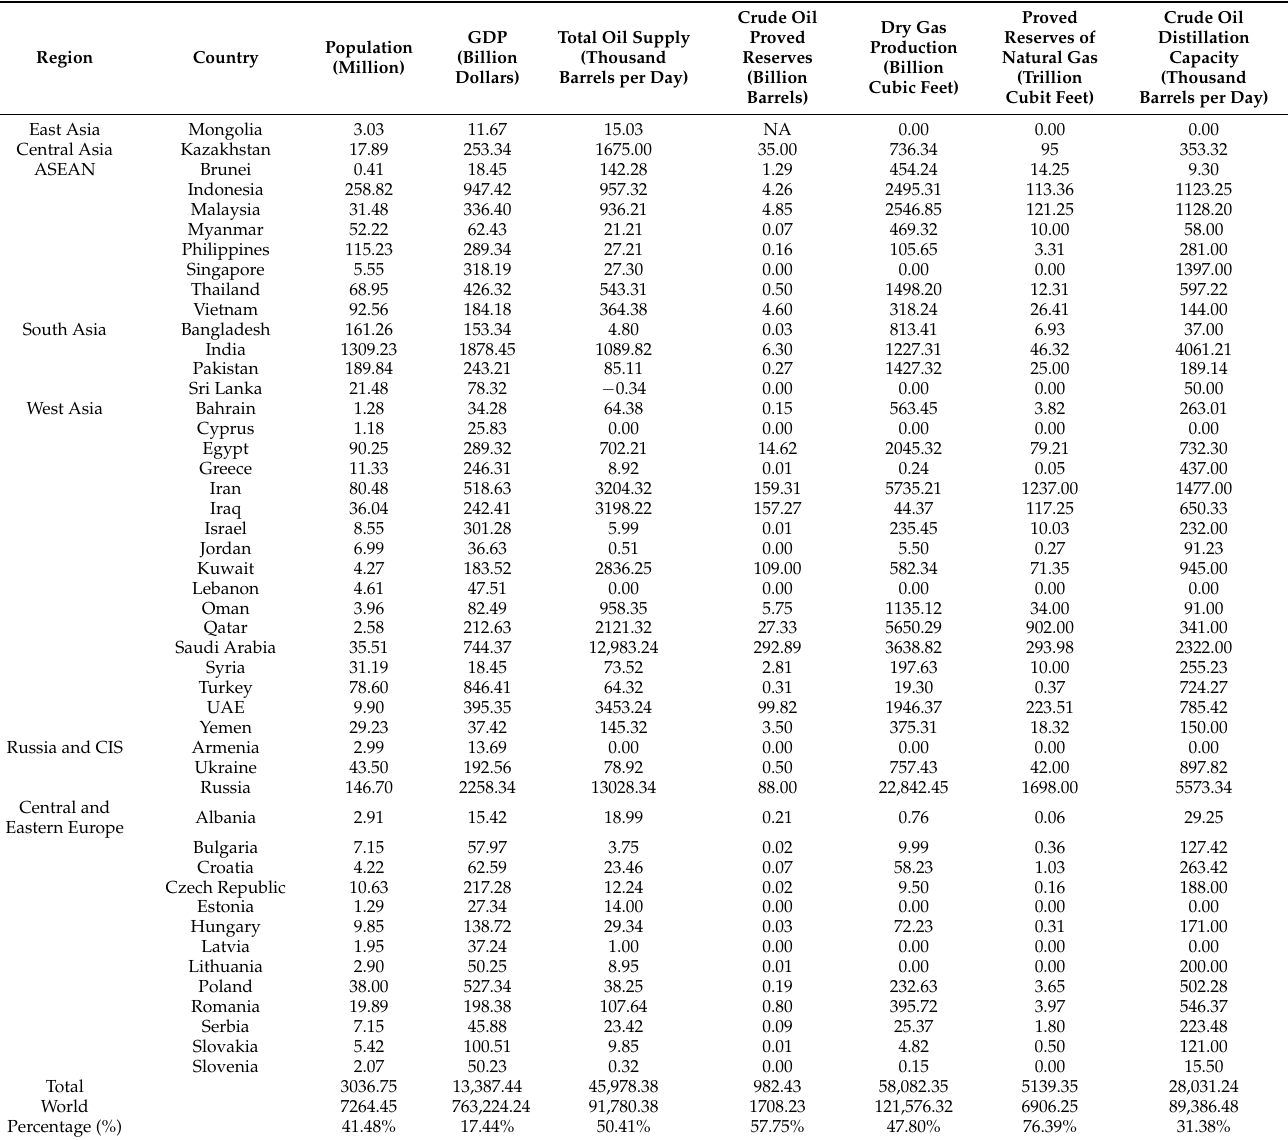
Table 2. Main average statistics of 50 Nations alongside the China’s “Belt & Road Initiative” during the period from 2013 to 2019”.